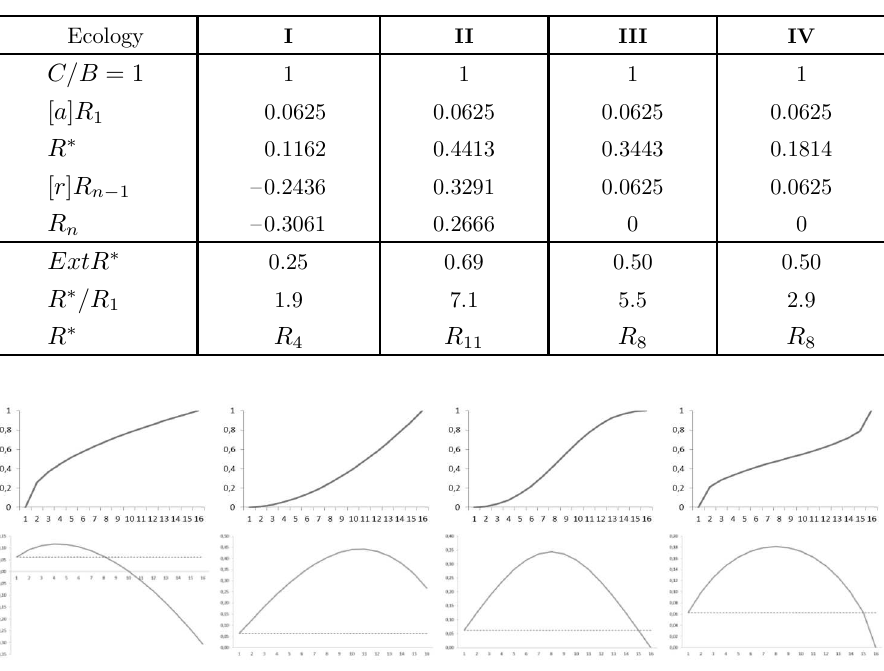
Models of ecosystems with a variable function Q (Ω) and function P ∗ (Ω) Ecology I II III IV C/B = 1